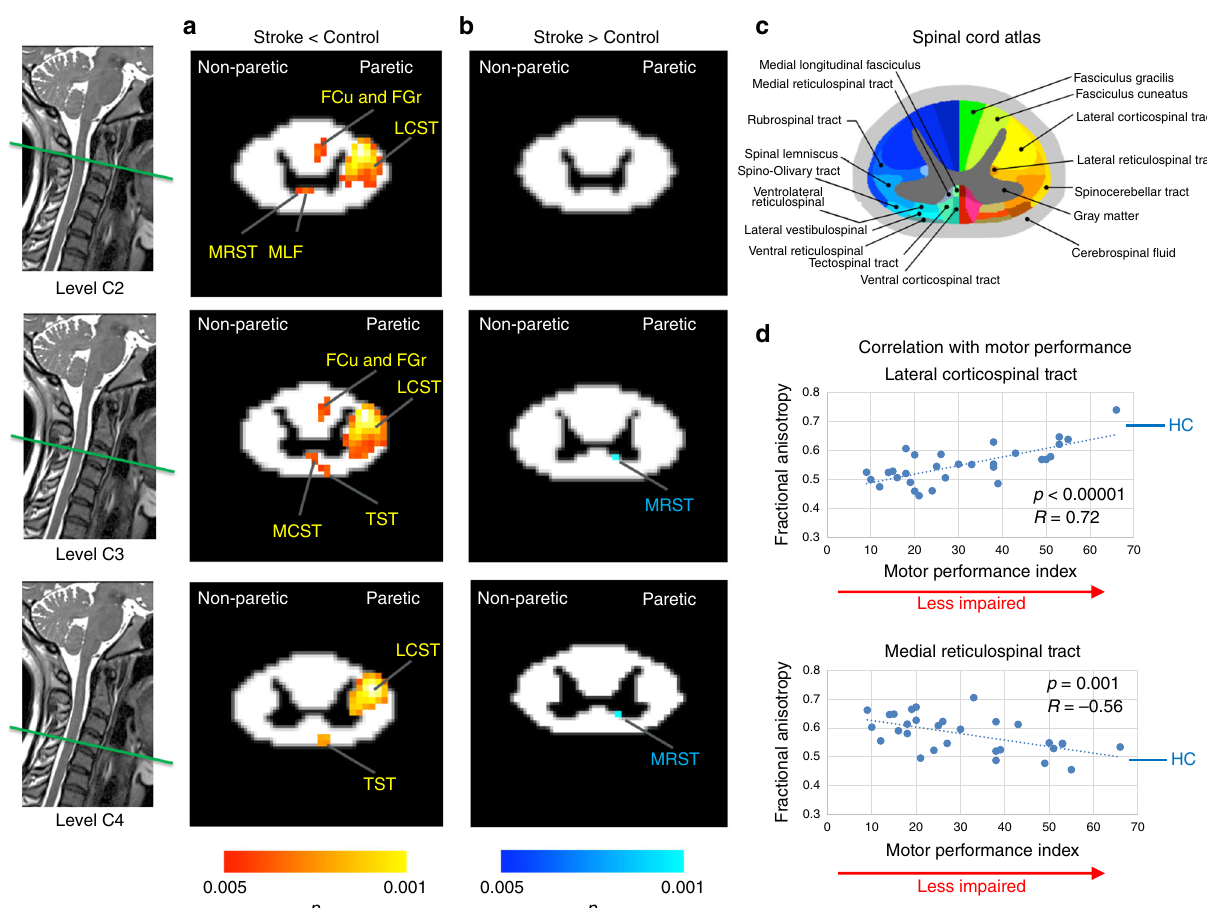
Fig. 3 White matter integrity changes in spinal cord of individuals with stroke compared to controls. a Tracts with signi fi cant decrease (red-yellow) in white matter integrity (fractional anisotropy (FA)). When compared to controls, individuals with stroke had signi fi cant decrease in white matter integrity of lateral corticospinal tract (LCST), cuneate fasciculus (FCu), gracile fasciculus (FGr), and tectospinal tract (TST) of the paretic side. These individuals also showed decreased white matter integrity in medial reticulospinal tract (MRST), medial longitudinal fasciculus (MLF), and medial corticospinal tract (MCST) of non-paretic side, which project ipsilaterally from the lesioned hemisphere. b Tracts with signi fi cant increase (blue) in white matter integrity. Medial reticulospinal tract of paretic side, which projects from non-lesioned motor cortices, had signi fi cant increased white matter integrity in individuals with stroke compared to controls. (Statistical test: between-group two-sample t test. Voxel-wise p < 0.005 was applied and the cluster-level corrected at p = 0.05.) c High-resolution spinal cord white matter atlas derived from the Gray ’ s Anatomy Atlas, adapted from ref. 42 . d Correlation of signi fi cant white matter integrity changes in individuals with stroke with their motor impairment level. Decreases in lateral corticospinal tract in individuals with stroke had signi fi cant positive correlation with their impaired motor performance. Increases in medial reticulospinal tract in individuals with stroke showed a negative correlation with their impaired motor performance. Paretic refers to the side of non-lesioned hemisphere (contralesional). Blue line with abbreviation HC indicates the mean of FA value in healthy controls for lateral corticospinal tract (equal to 0.68) and medial reticulospinal tract (equal to 0.49). Fugl – Meyer Assessment (FMA) score is missing for one participant. Source data are provided as a Source Data fi le anatomical scans were acquired using an MPRAGE (magnetization-prepared rapid 769 ms, in-plane resolution = 0.4× 0.4mm 2 , slice thickness = 5mm, number of gradient echo) sequence with voxel size = 0.8 ×0.8 ×0.8 mm, repetition time slices = 15, and the scan duration = 5:11min. (TR) = 9.9ms, echo time (TE) = 4.6ms, fl ip angle = 2°, and fi eld of view (FOV) = 256 mm. Brainstem diffusion-weighted images (DWIs) were collected using spin- Brainstem DTI data preprocessing . The DWIs were pre-processed using the echo echo-planner imaging with the following parameters: voxel size = 1.5 iso- FMRIB Software Library version 5.0.11 (FSL: Oxford Centre for Functional MRI of tropic, TR = 3620 ms, TE = 68.4 ms, matrix size = 150 ×150, FOV = 222 × 222 the Brain, UK; http://www.fmrib.ox.ac.uk/fsl/) 52,53 . Raw DTI data were corrected mm 2 , slice thickness = 1.5 mm, interslice gap = 0mm, and number of slices cov- for eddy current distortions using the Eddy Current Correction tool and for motion ering whole brain and brainstem = 108. The sequence consisted of diffusion using the McFlirt Motion Correction tool. The FMRIB Brain Extraction Tool 54 was weighting of 1000 s/mm 2 in 60 different directions and 8 scans with no diffusion then used for skull stripping. Diffusion tensors were fi tted at each voxel and FA weighting ( b = 0s/mm 2 ). images were created using the DTIFIT tool of FMRIB FDT toolbox version 5.0 52 . Cervical spinal cord T2-weighted anatomical scans were collected with the resolution = 0.8 ×0.8 ×0.8, TR = 1500 ms, TE = 100 ms, FOV = 256 ×256 mm 2 , number of slices = 64, and scan duration = 4:35 min. Cervical spinal cord DWI Brainstem tract-based spatial statistics analysis . Majority of stroke participants scans were collected from level C2 to C5 with four acquisitions averaged of fl ine had lesion in the left hemisphere. For those individuals with lesions in the right with the following parameters: in-plane resolution = 0.8× 0.8, TR = ~600 ms hemisphere, FA maps were fl ipped so that all subjects had lesions in the left hemi- (depends on heart beat), TE = 61ms, slice thickness = 5mm, interslice gap = 0 sphere for group analysis. Voxel-wise statistical analysis of the DTI FA images was mm, FOV = 86 mm 2 , number of slices = 15, b value = 1000 in 30 directions, 4 carried out using tract-based spatial statistics (TBSS 55 ) in FSL. First, all subjects ’ FA images with b = 0, and scan duration = 6:35 min. For a better gray matter – white images were aligned to the standard 1×1×1mm 3 MNI152 template in FSL, using matter segmentation of spinal cord, we also collected a T2*-weighted scan that used the non-linear registration tool (FNIRT). Next, the mean FA image was created and multi-echo recombined gradient echo with three echoes at 5, 10, and 20ms, TR = thinned to create a mean FA skeleton representing the centers of all tracts, using a NATURE COMMUNICATIONS| (2019) 10:3524